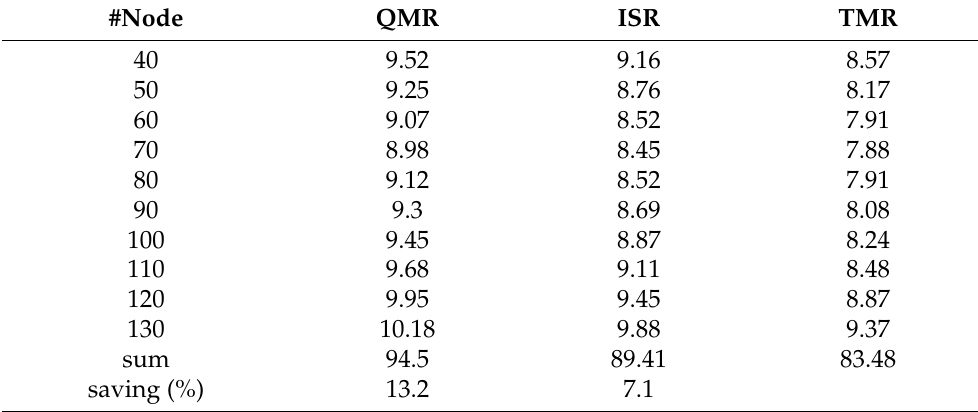
Figure 32. Comparison of QMR, ISR, and proposed protocol TMR for throughput with number of nodes. Table 7. Number of nodes vs. PLR of Figure